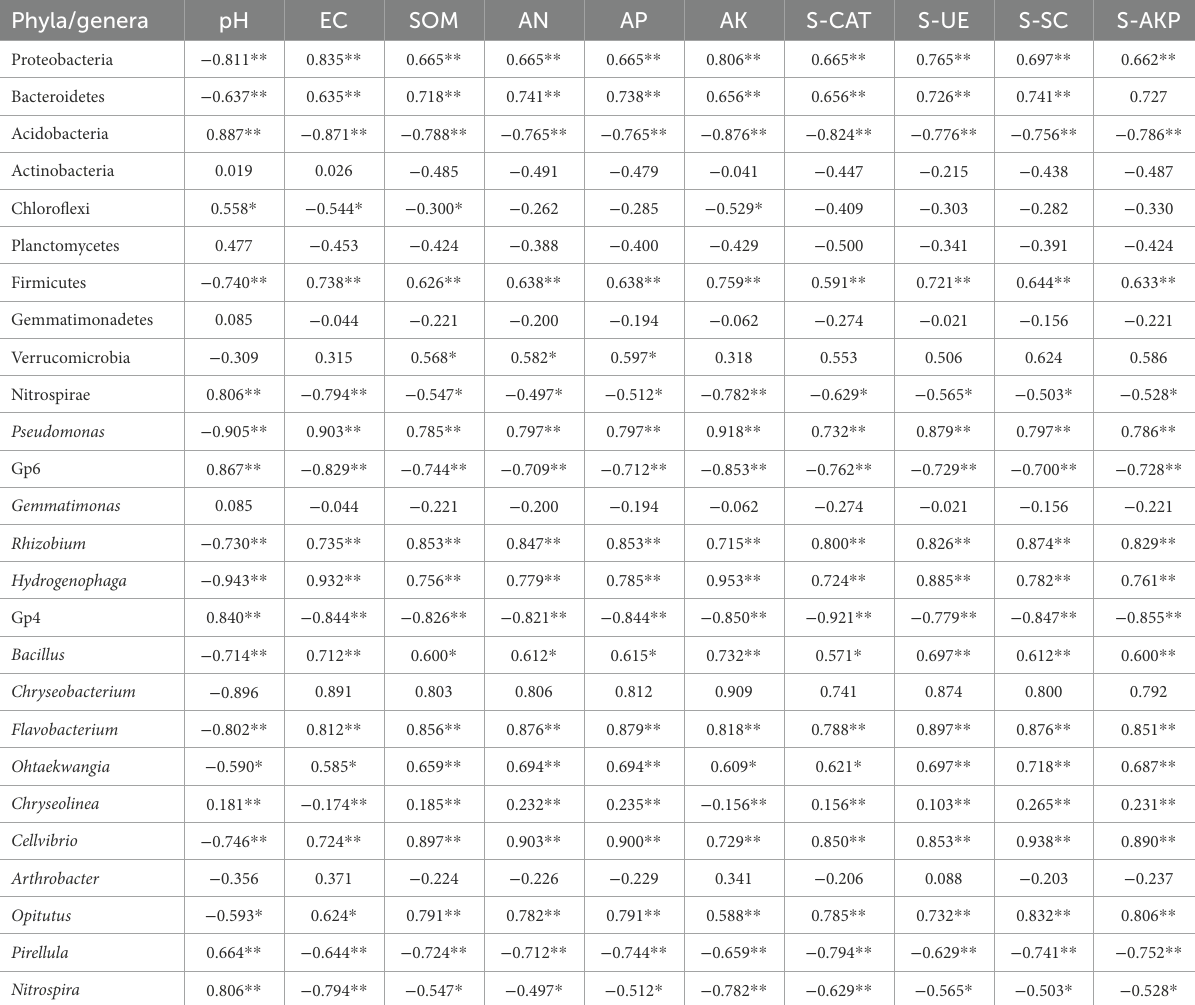
TABLE 2 Spearman’s rank correlations between abundant bacterial phyla/genera and soil properties.